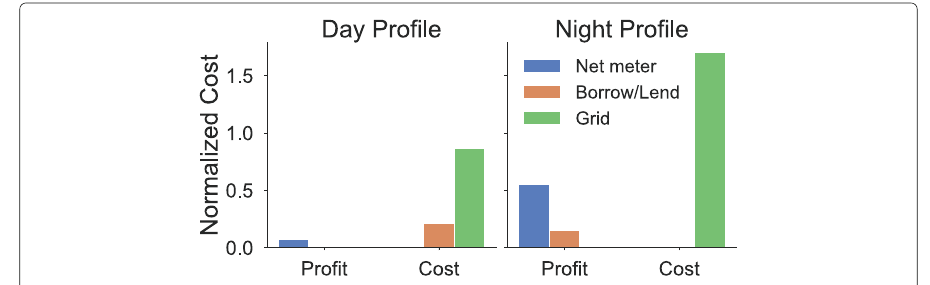
Fig. 9 Example cost distribution of homes for day and night demand